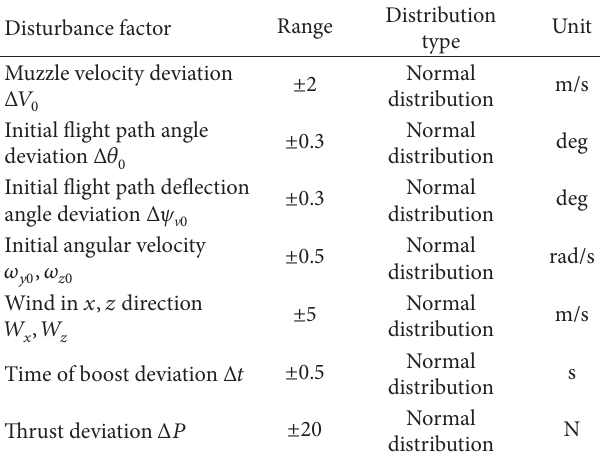
Table 1: Disturbance factors and their distribution.